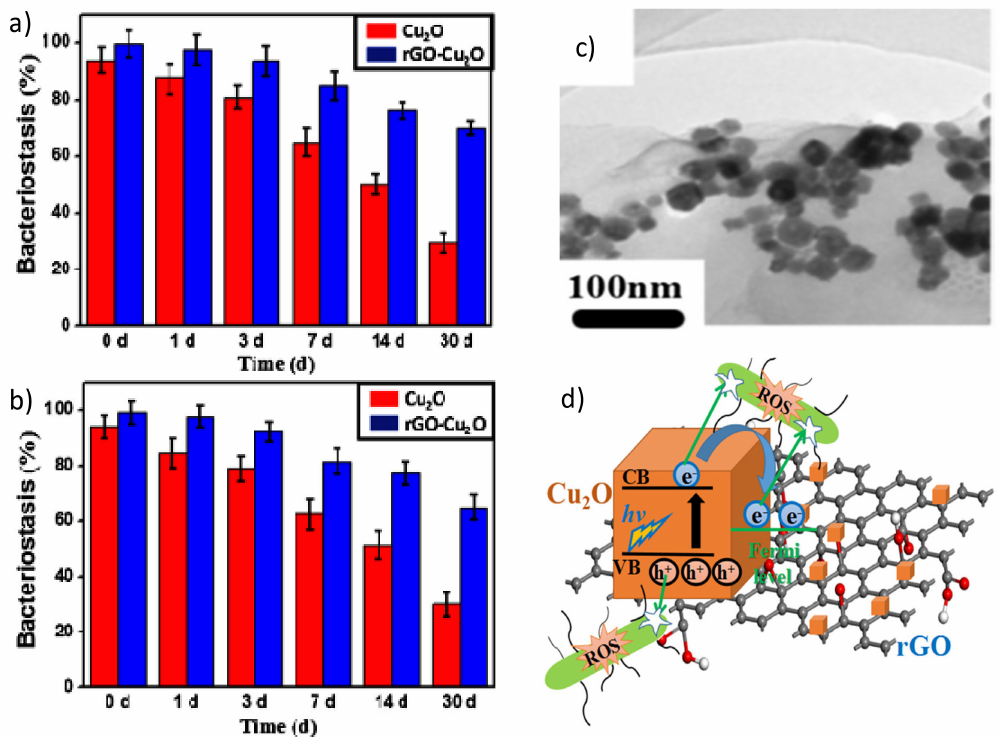
Figure 7. Percentage of bacterial reduction of E. coli ( a ) and S. aureus ( b ) in the presence of Cu 2 O nanoparticles and the Cu 2 O-rGO nanocomposite after immersion in phosphate bu ff ered saline (PBS) for di ff erent days. TEM image of the Cu 2 O-rGO nanocomposite ( c ). Schematic representation of the mechanism of ROS production of the Cu 2 O-rGO nanocomposite ( d ). Reproduced from Ref. [71], with permission from Elsevier, 2019.